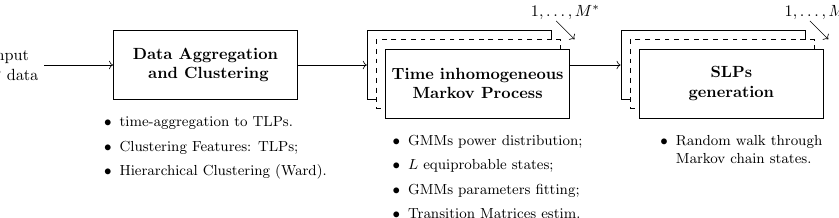
Figure 1. Block diagram summarizing the main steps of the proposed SLP generation model. The key tasks of each step are also